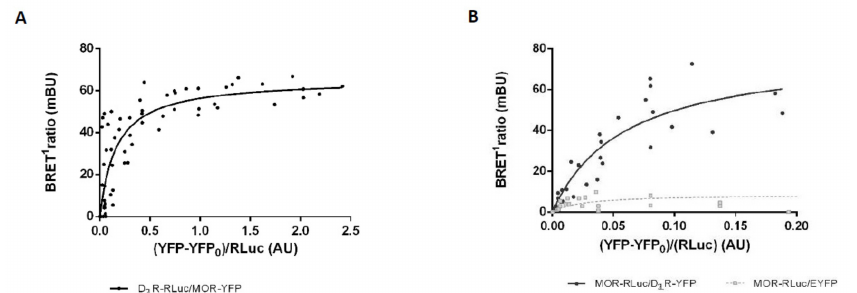
Figure 3. Assessment of D 2L R receptor dimerization with MOR using saturation bioluminescence resonance energy transfer (BRET 1 ) assay. Saturation BRET 1 assay was performed in HEK 293T cells transfected with a fixed amount of the donor plasmid: D 2L R- R Luc ( A ) or MOR- R Luc ( B ) and increasing amounts of the acceptor plasmid: MOR-YFP ( A ) / D 2L R-YFP ( B ) / EYFP ( B ). The data represent three–four independent experiments, fitted using nonlinear regression equation, assuming a single binding